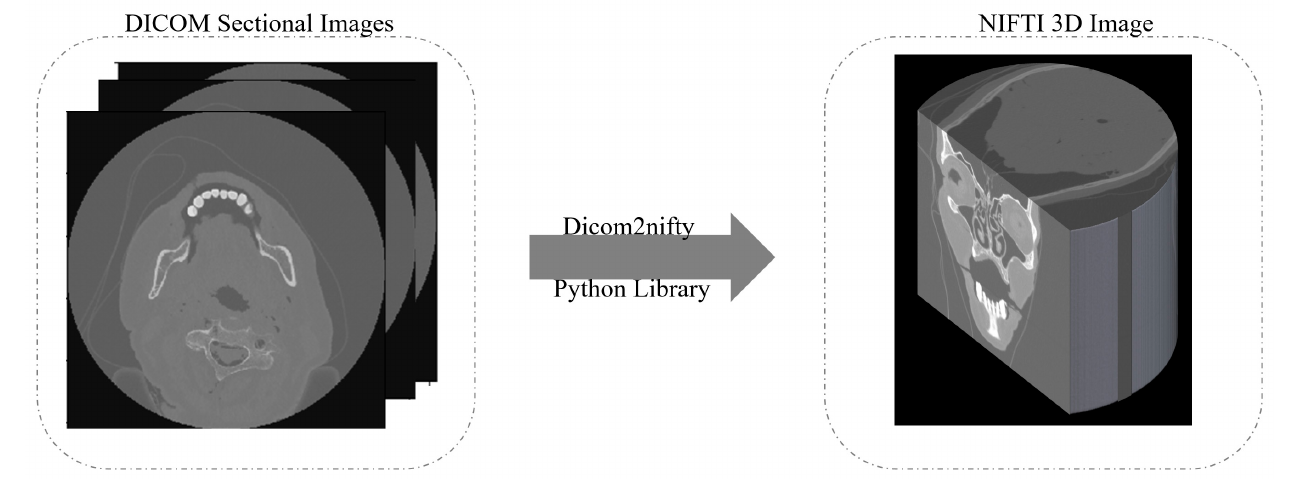
Figure 2. 3D image construction to convert DICOM files into 3D NIFTI images.